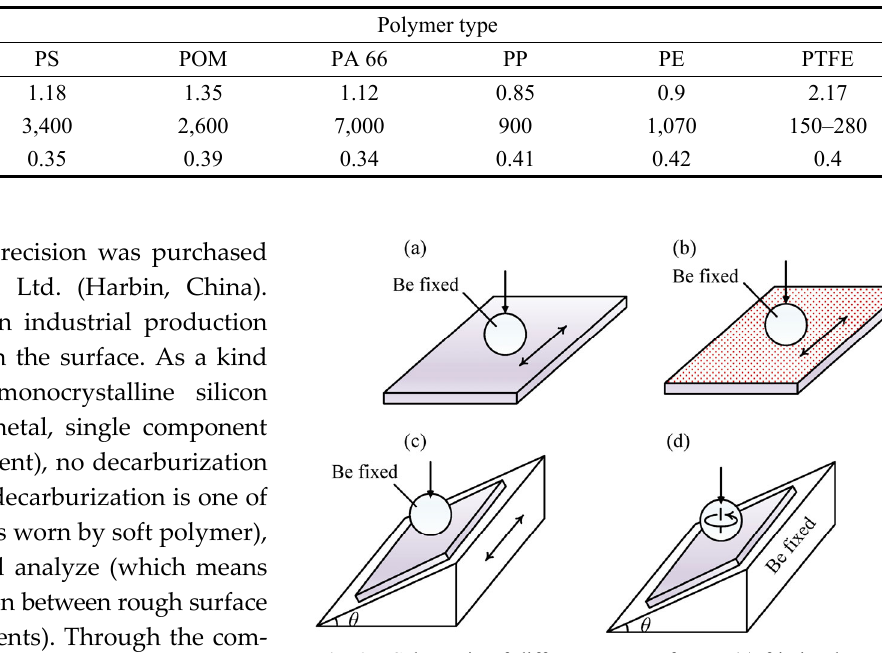
Table 1 Physical properties of the six polymers provided by the